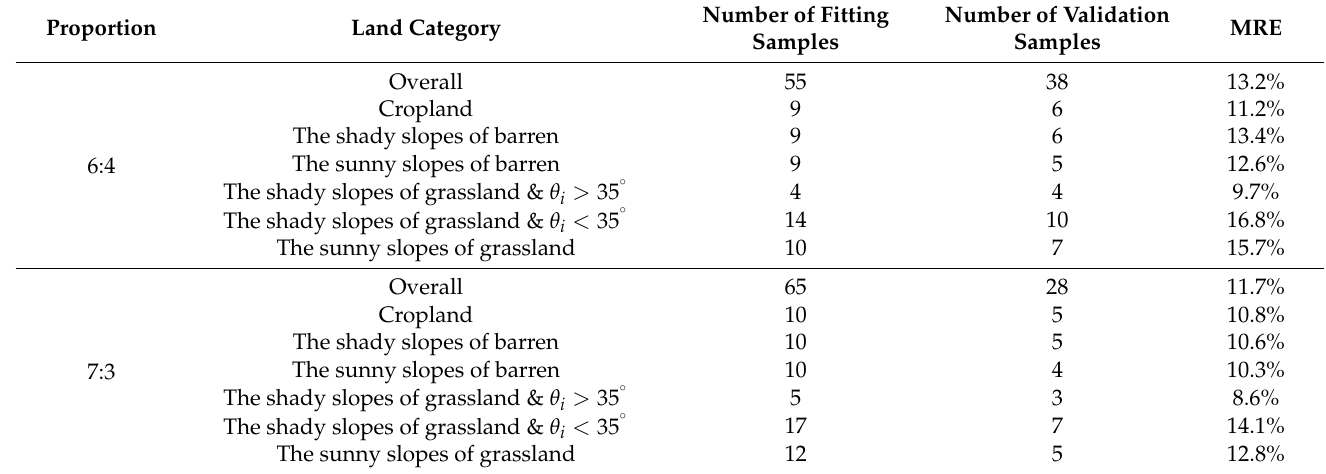
Table 8. Different proportions of optimization model accuracy